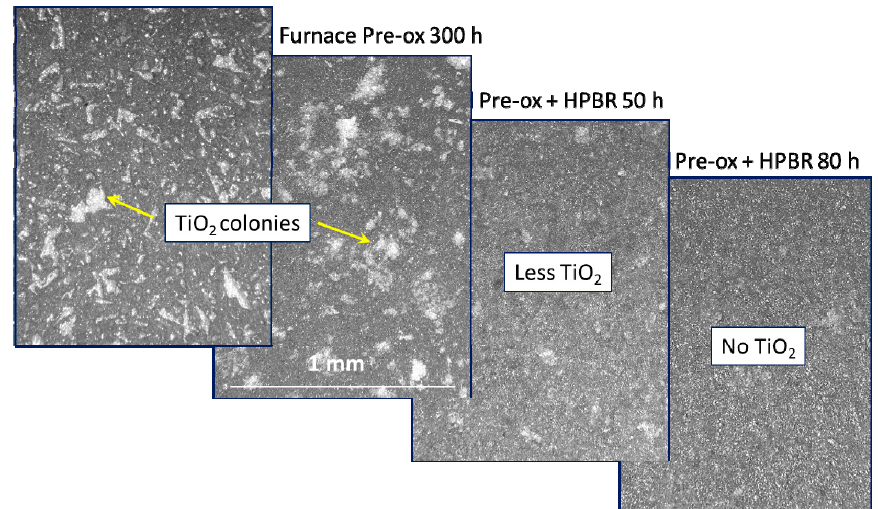
Figure 4. Optical micrographs depicting discontinuous TiO 2 scales formed in furnace tests and successive removal in HP-BRT exposures at 1300 °C.